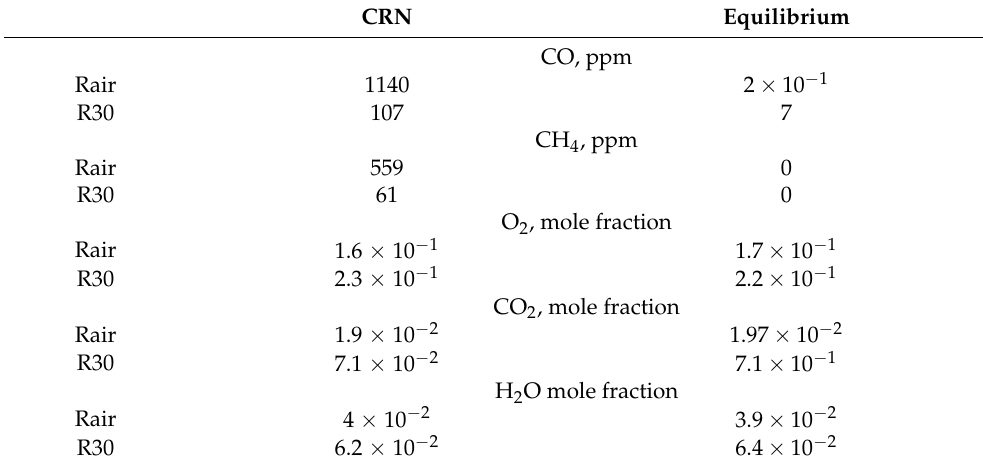
Table 7. Comparison between CRN and equilibrium emissions. CRN Equilibrium CO,